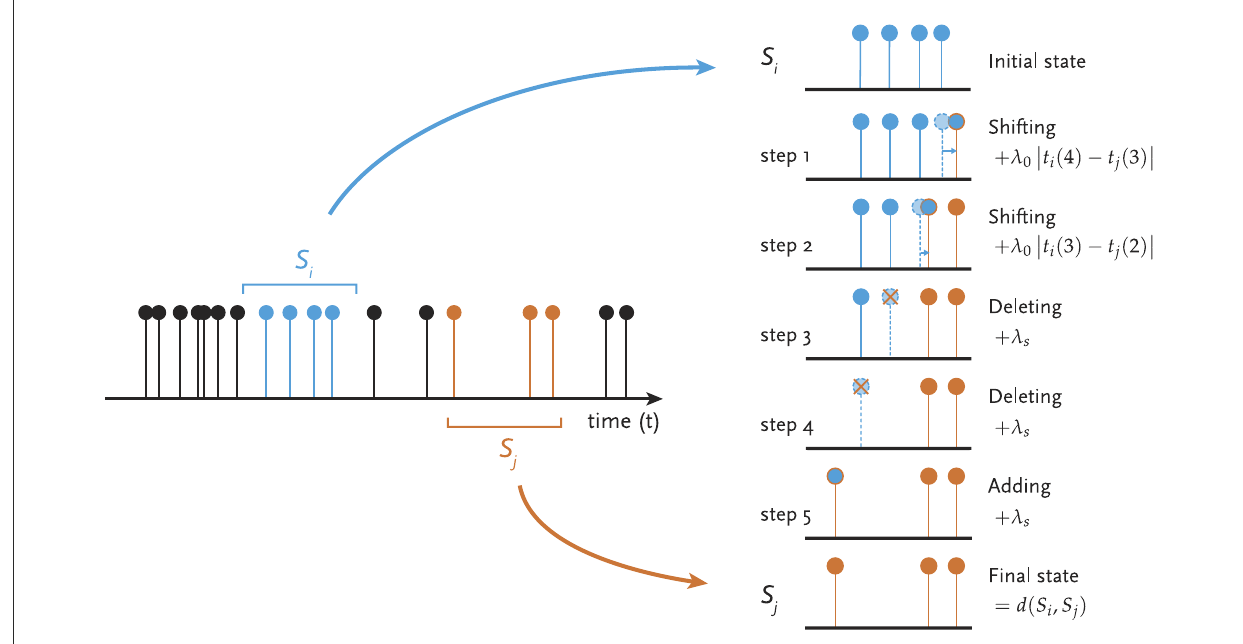
FIGURE1 Edit distance as cost-based similarity between event sequences S i and S j from an event series (left) . Events can be shifted, added or deleted, and their amplitude adjusted. All these operations have costs. The minimum cost is used as the distance d ( S i , S j ) (right) .